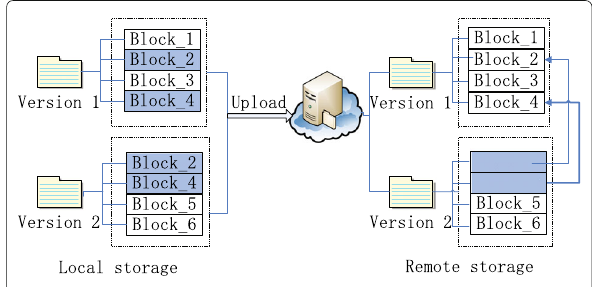
Fig. 5 Comparison between local and remote storage of version